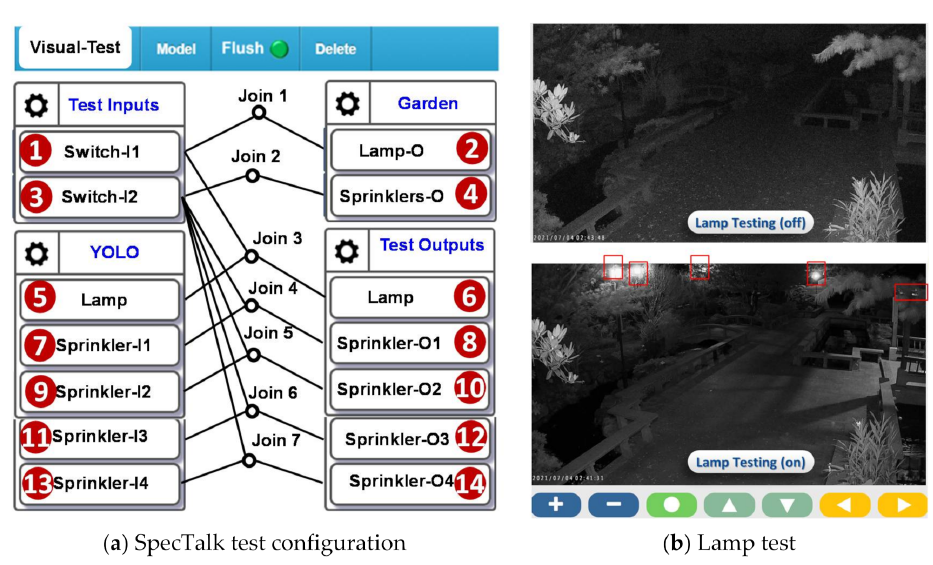
Figure 23. The visual-test configuration for a fountain in the Ming Der High School, Taichung.